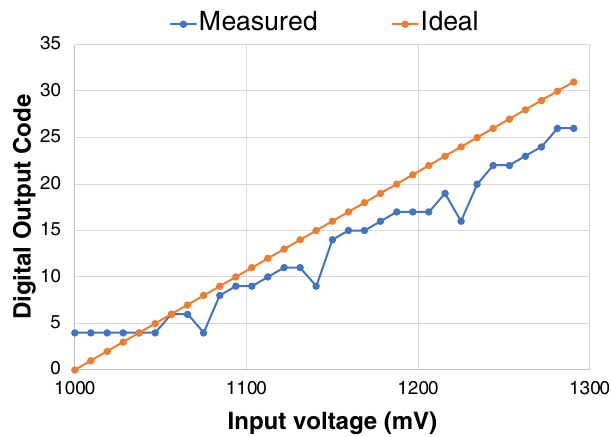
Fig.6|ADCmeasurement. ThemeasuredADCoutputisshownin300mVrangeat 1C offset with respect to the ideal ADC